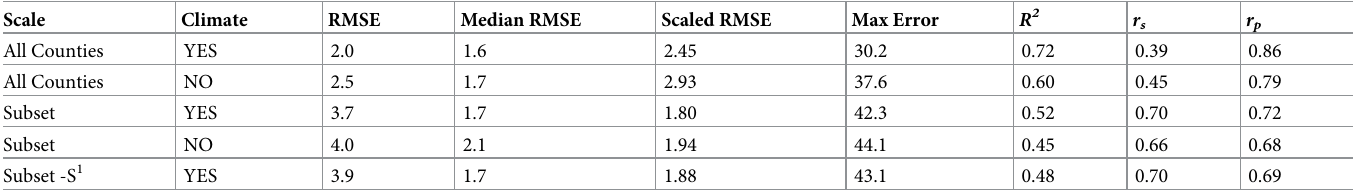
Table 3. Model fits for the human data at the county-scale. The All Counties analysis was based on 882 county × year records, while the subset contained 206 county × year records for which surveillance data were available. RMSE, Max Error, Median RMSE, Scaled RMSE, R 2 , r p , and r s are defined in Methods : model fit statistics